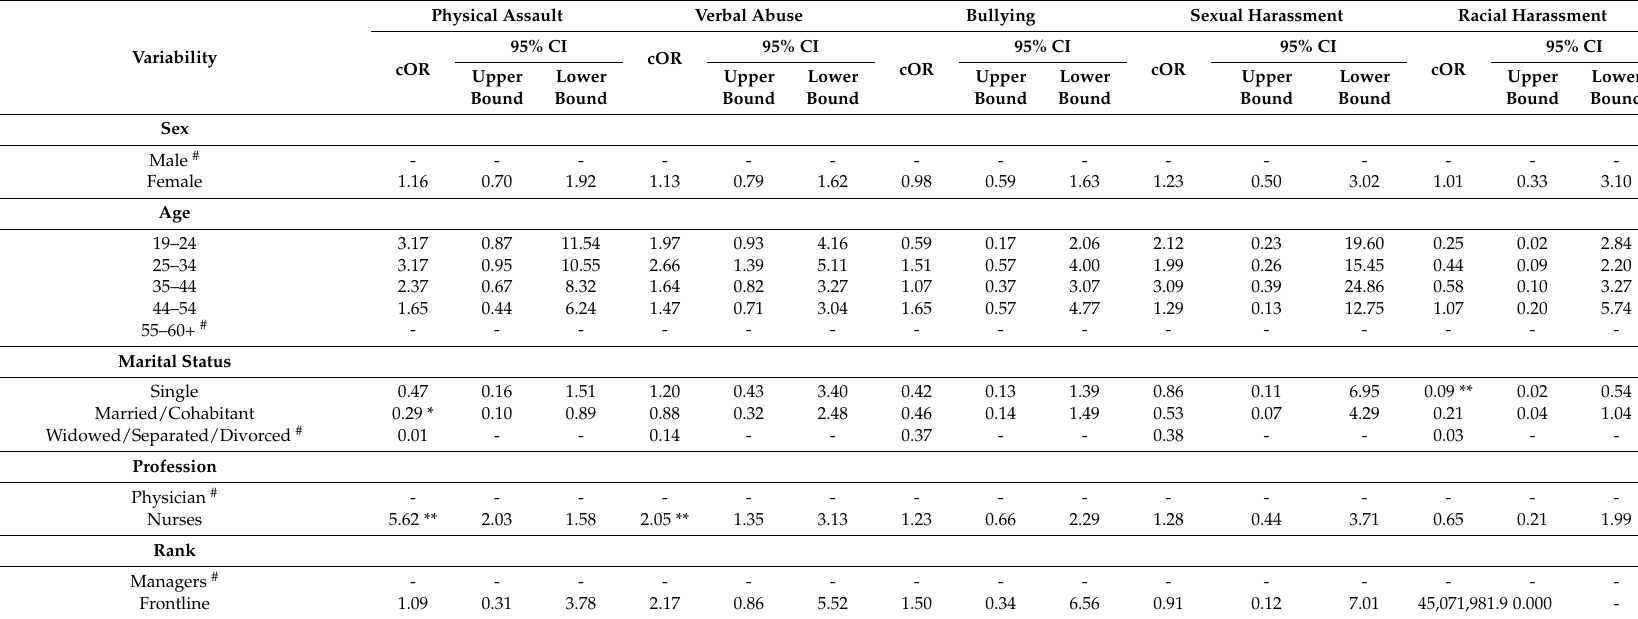
Binary logistic regression analysis between physical assault, verbal abuse, bullying, sexual harassment, racial harassment, and other socio-demographic